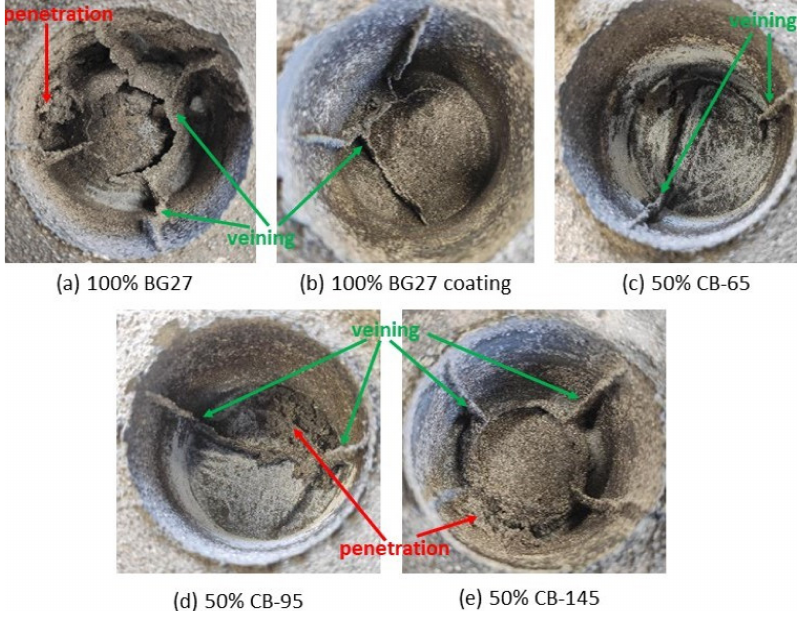
Figure 5. Appearance of surface defects such as veining and penetration on BG27 reference castings and castings with 50% CB